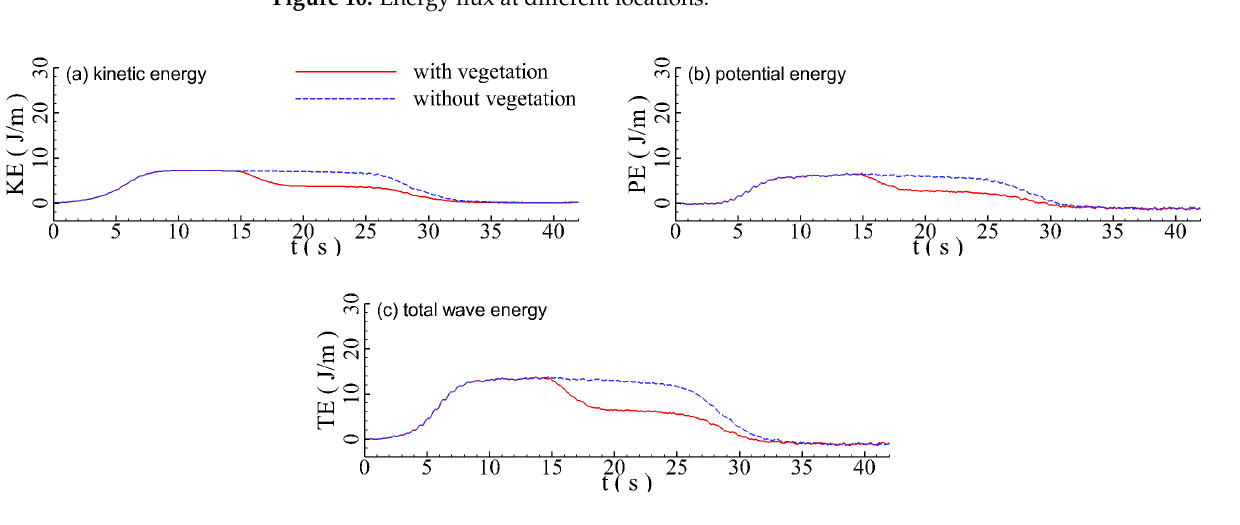
Figure 10. Energy flux at different locations.